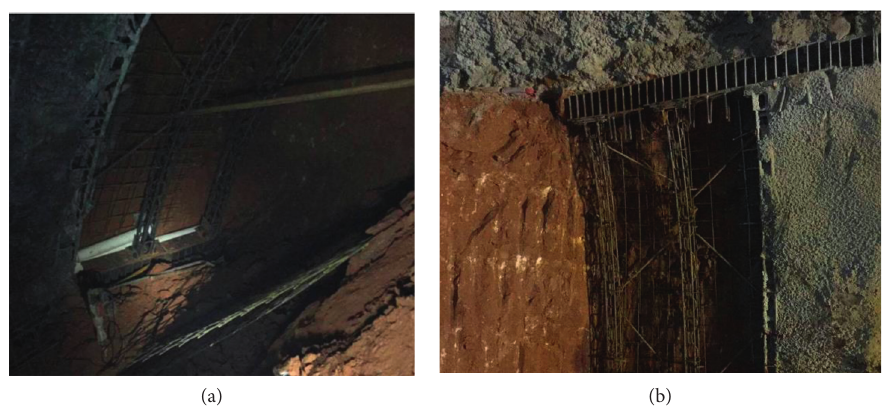
Figure 10: SRLD after construction. (a) Upper step. (b) Middle step.